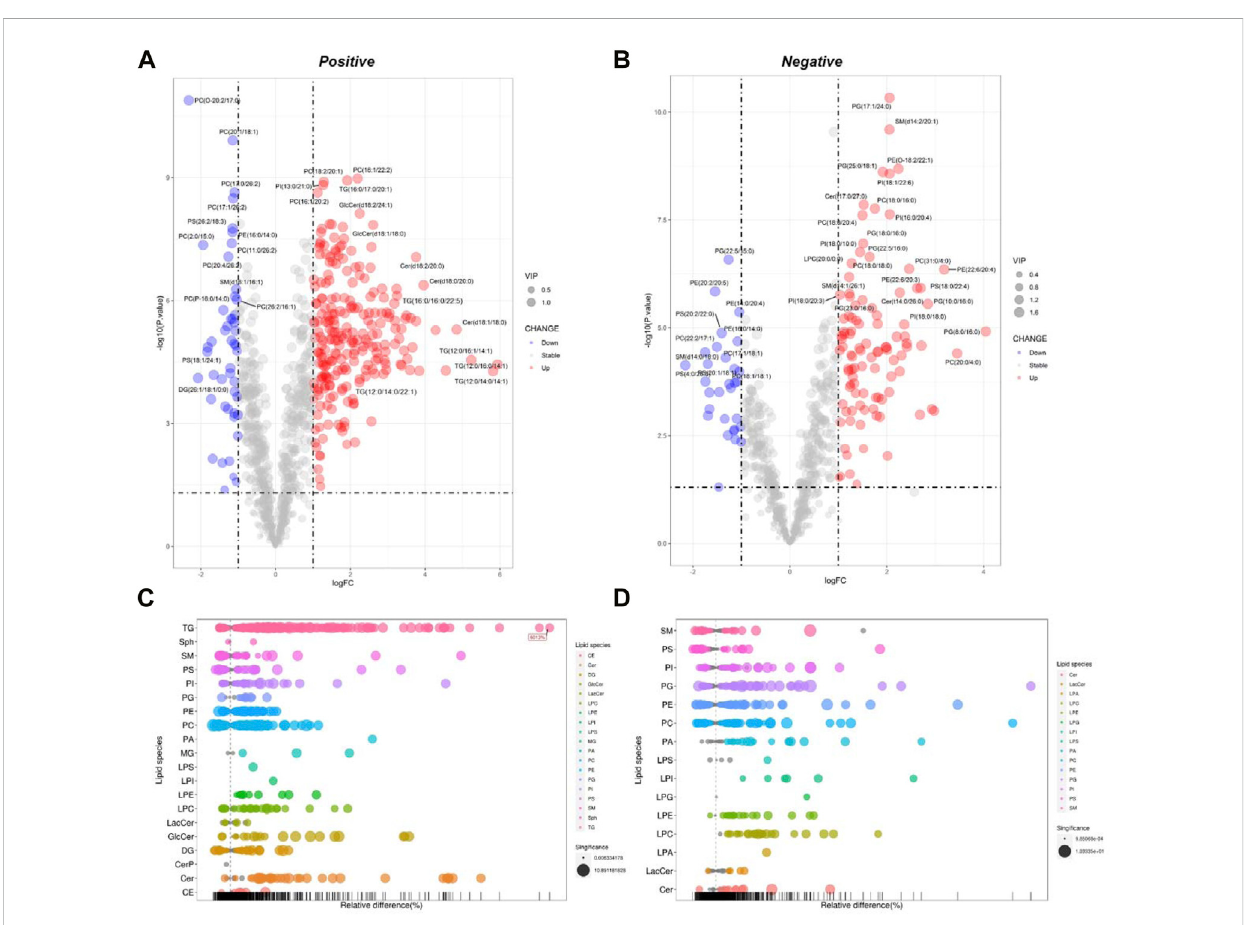
FIGURE 2 Analysisofsigni fi cantlydifferentiallipidsubstancesinthePalgroup versus theCtrlgroup.Volcanoplots (A,B) andlipidplots (C,D) inbothpositiveand negative ionmodes,respectively.Inthevolcano plot,lipid specieswerescreened outbased onthecriteriaof p < 0.05, VIP ≥ 1,andfold change < 0.5or >